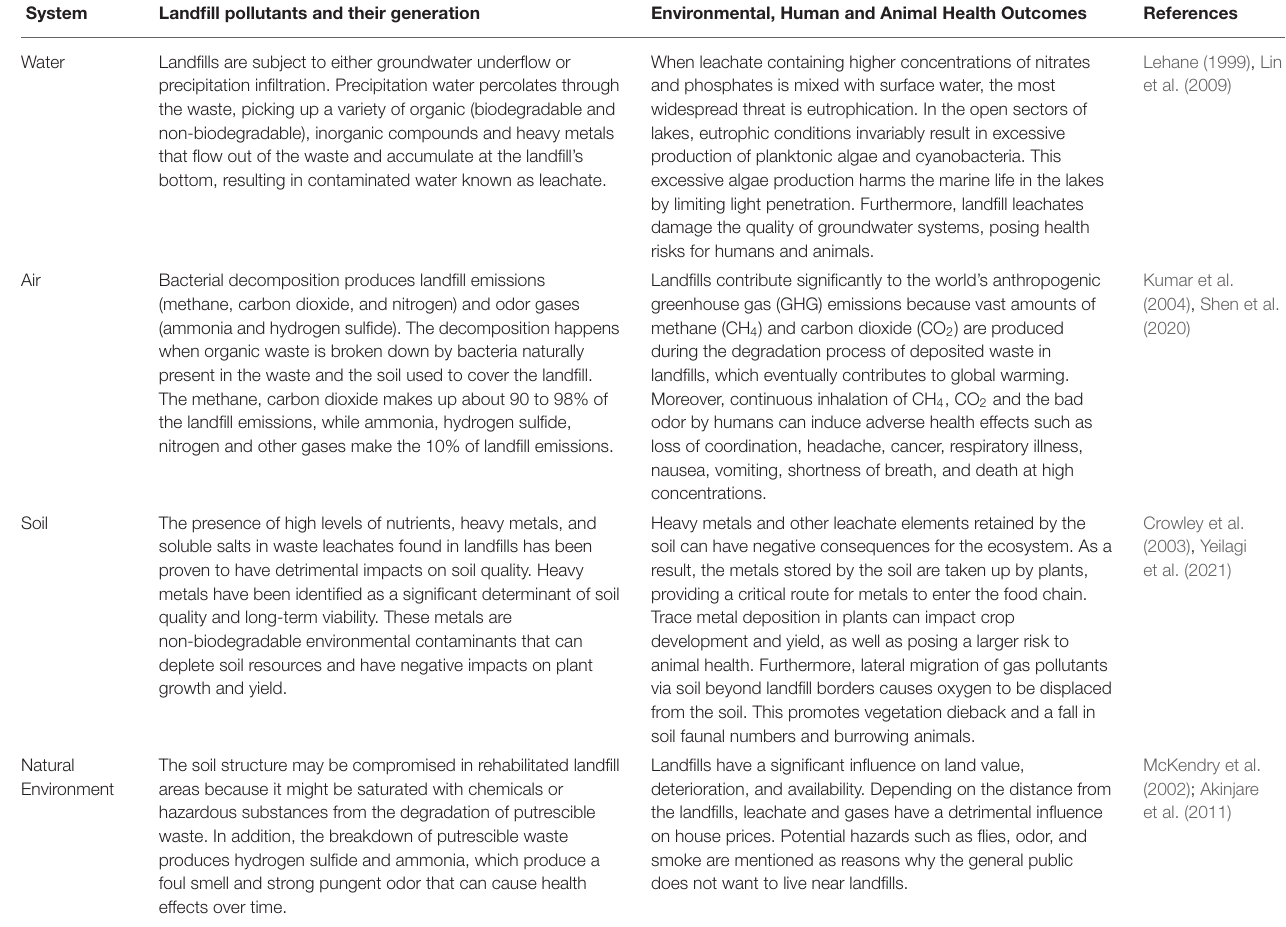
TABLE 2 | Potential environmental impacts of direct landfill disposal and incineration of fruit pomaces.